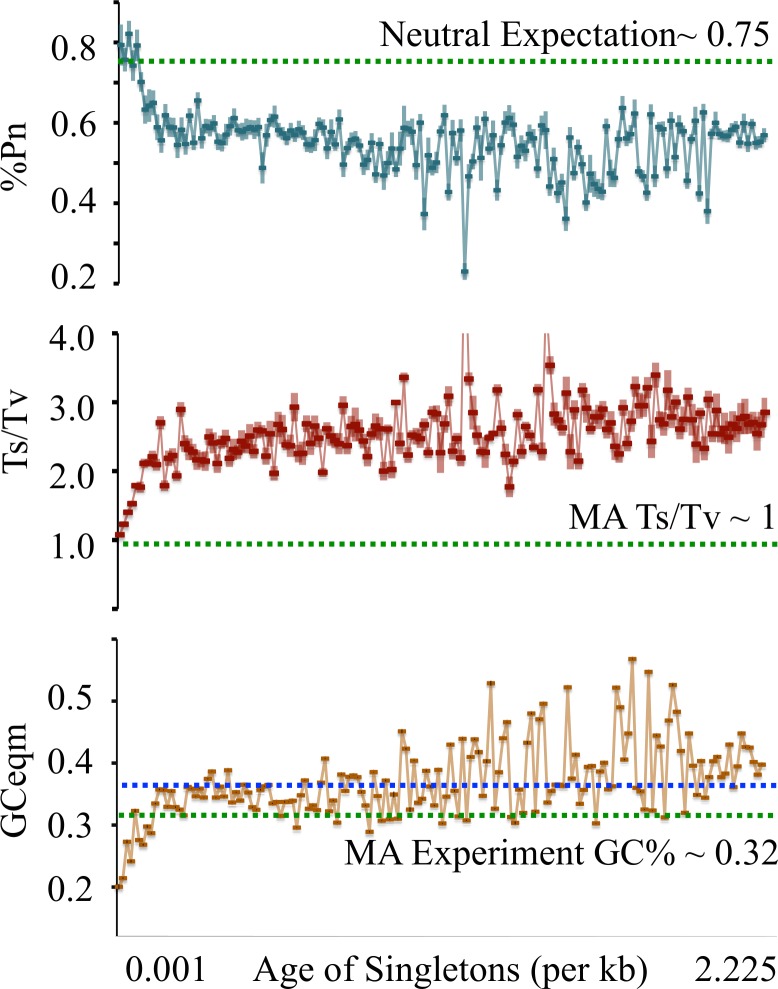
%Pn, Ts/Tv and GCeqm trends across SNP singleton age.%Pn and Ts/Tv values reach MA/neutral expectations in the lowest SNP frequencies (highlighted in box). GCeqm surpasses MA experimental values. X-axis–singletons from youngest to oldest. Y-axis–%Pn, Ts/Tv, GCeqm.